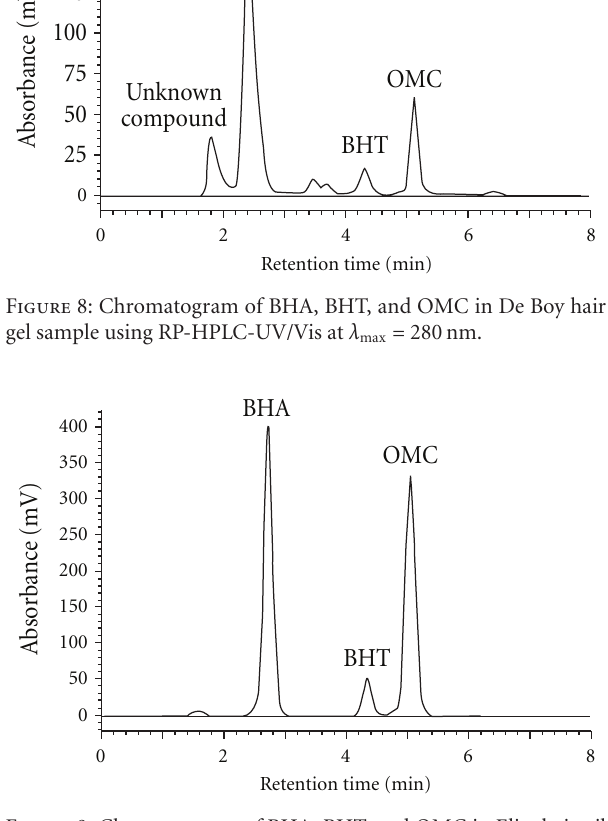
Figure 9: Chromatogram of BHA, BHT, and OMC in Elite hair oil sample using RP-HPLC-UV/Vis at λ max =